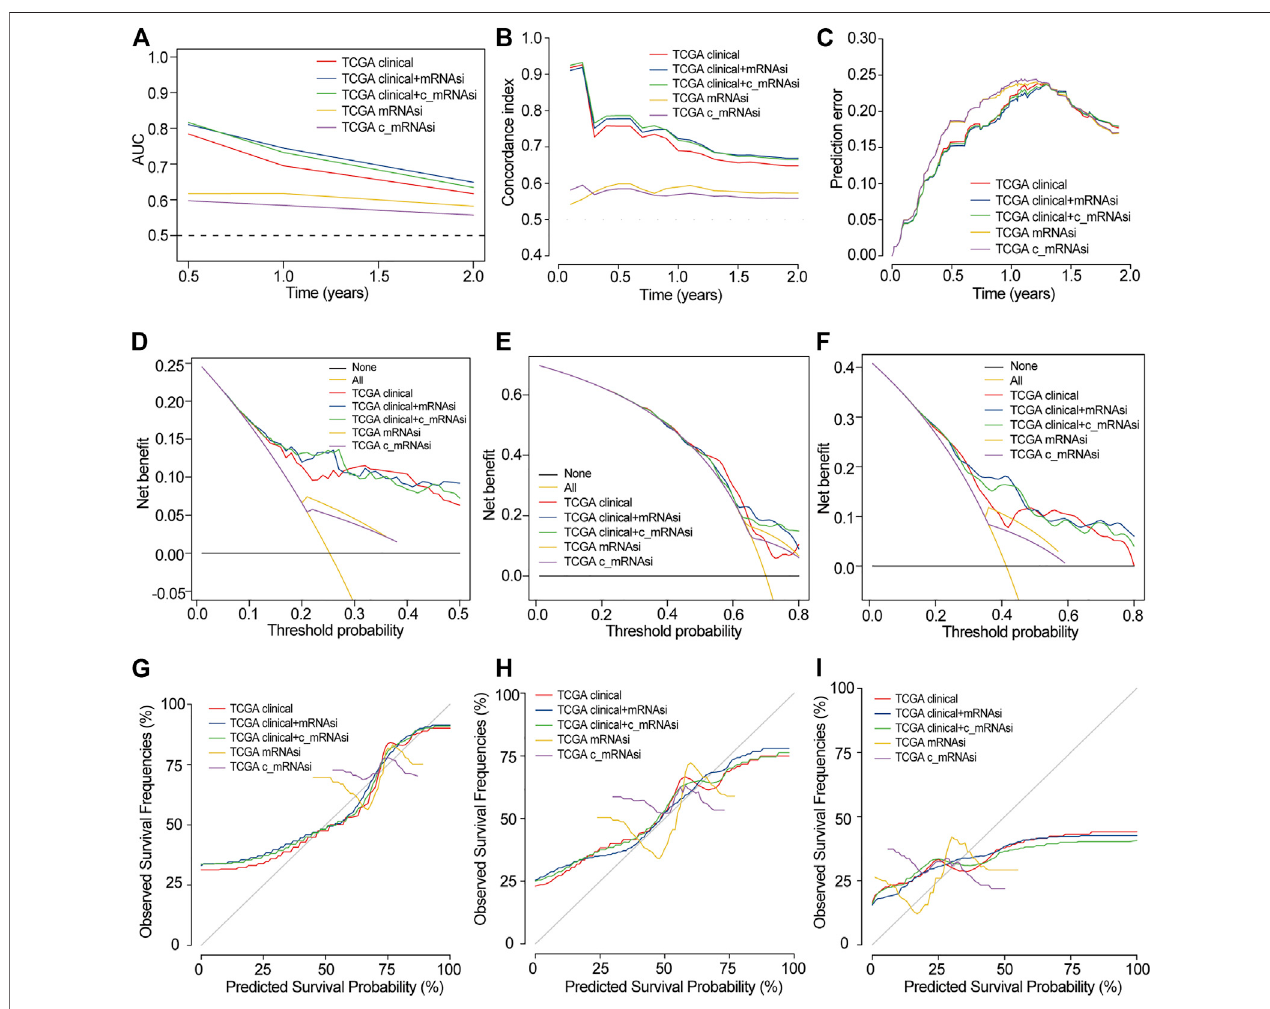
FIGURE5| Evaluationofprognosticmodels inTCGA. (A) .AUC inTCGA. (B) .C-indexinTCGA. (C) .Prediction errorinTCGA. (D) .0.5-yearsDCAinTCGA. (E) .1- year DCA in TCGA. (F) . 1.5-years DCA in TCGA. (G) . 0.5-years calibration in TCGA. (H) . 1-year calibration in TCGA. (I) . 1.5-years calibration in TCGA.